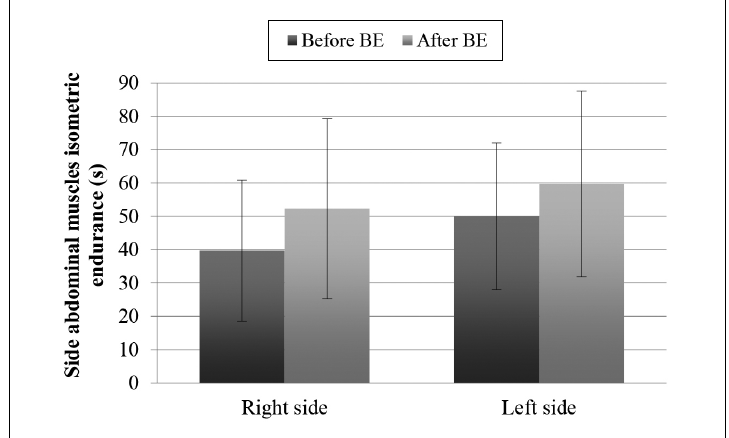
Note. * p < .05 compared with the result of physical